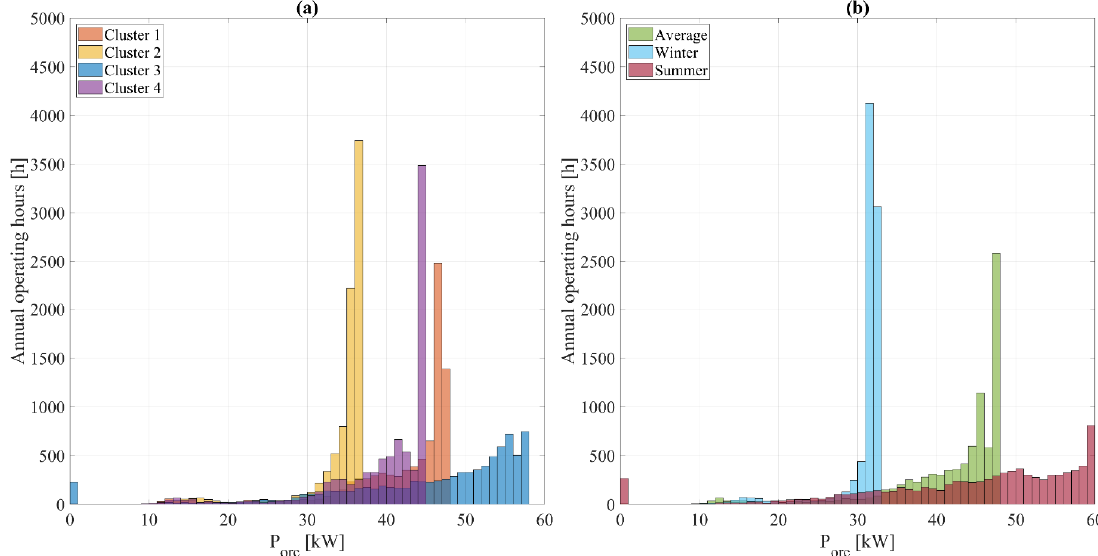
Figure 10. ORC net power output in off-design for the whole year operation. The results are related to the ORC systems built on the basis of the boundary condition sets listed in Table 2 . ( a ) The four data clusters. ( b ) All the other configurations (annual, summer, and winter average) in Table 2 .